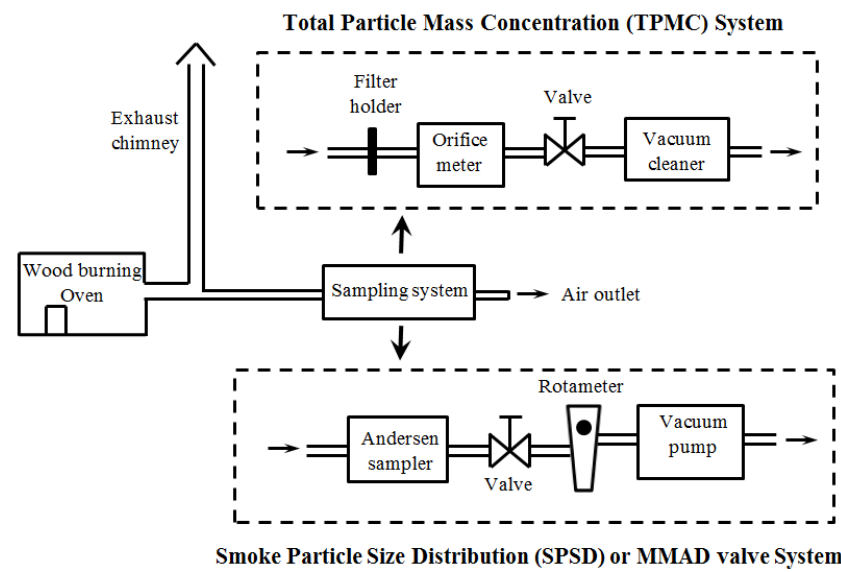
Figure 1. Schematic diagram of smoke particle sampling methods for TPMC and MMAD value cal-